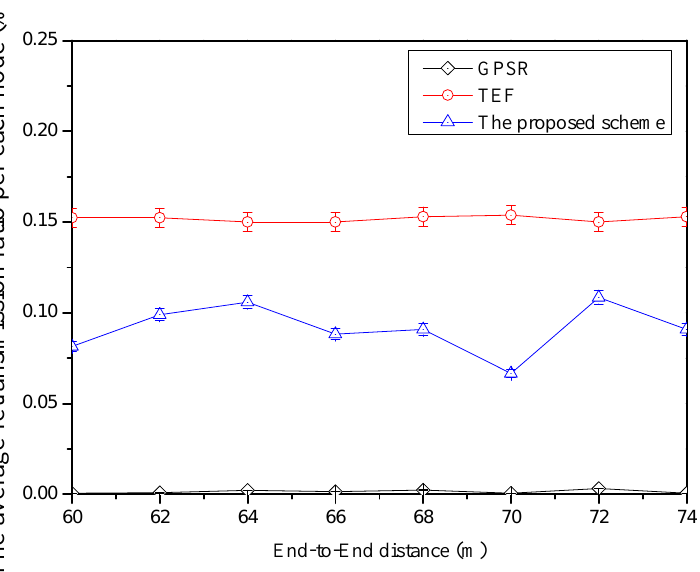
Figure 10. The comparison of the average retransmission ratio per node according to end-to-end dis-